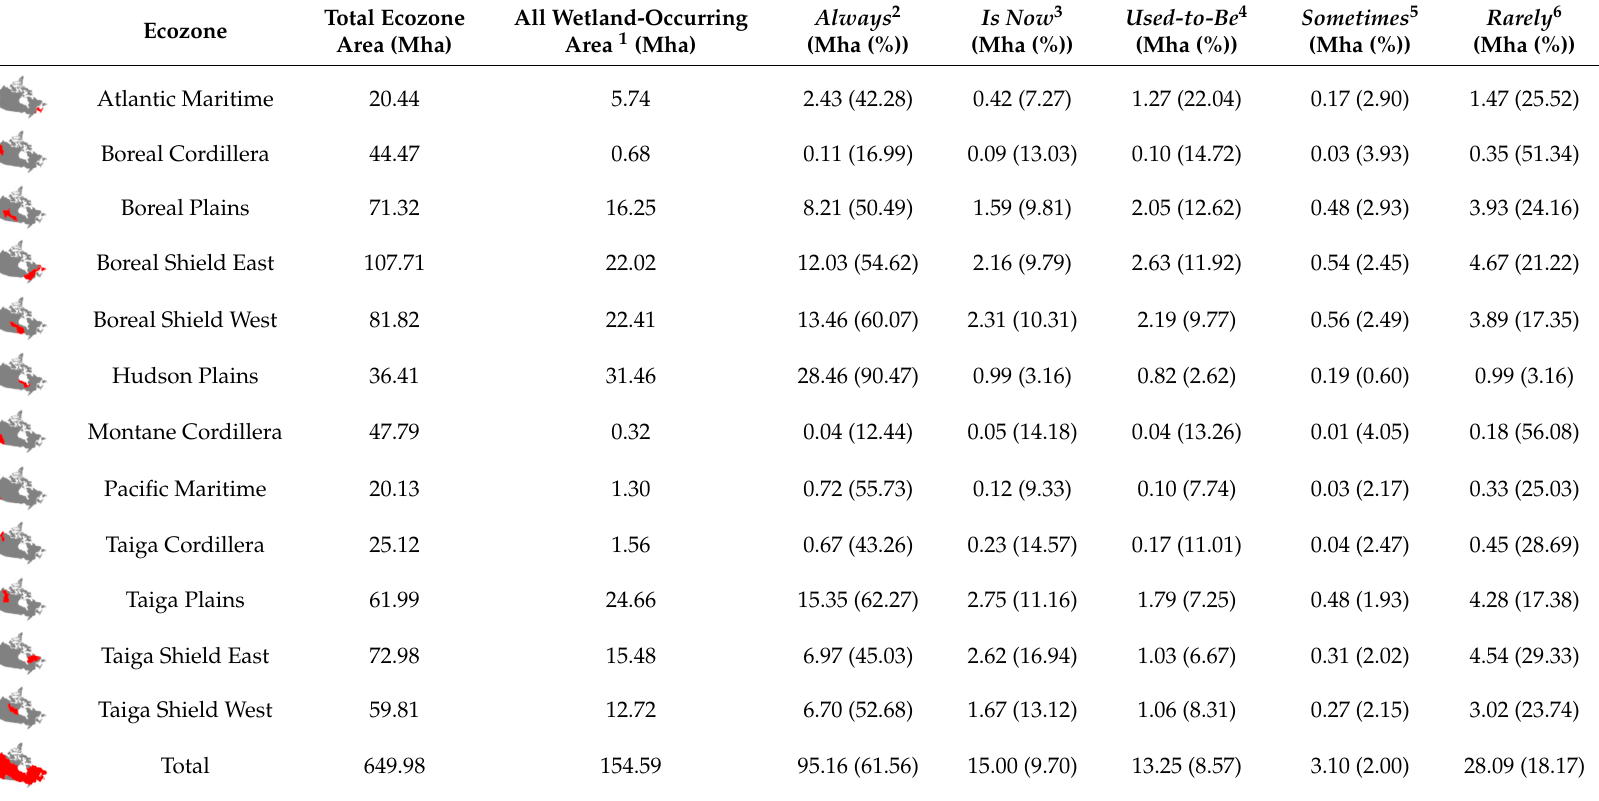
Table 3. Summary of wetland temporal state (in millions of hectares, MHa) over the period, 1984–2016. Numbers in parentheses are the percentages of all the wetland-occurring area per ecozone in each temporal state.